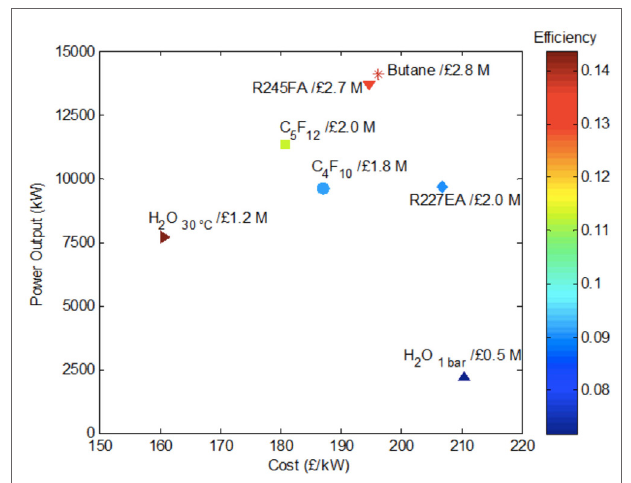
FiGURe 9 | Consolidated plot of power output, efficiency and cost from Rankine cycles with water and indicated organic fluids corresponding to the results contained in Figures 6–8